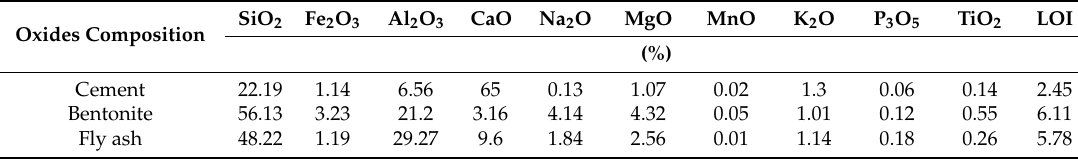
Table 1. Chemical composition of binders.